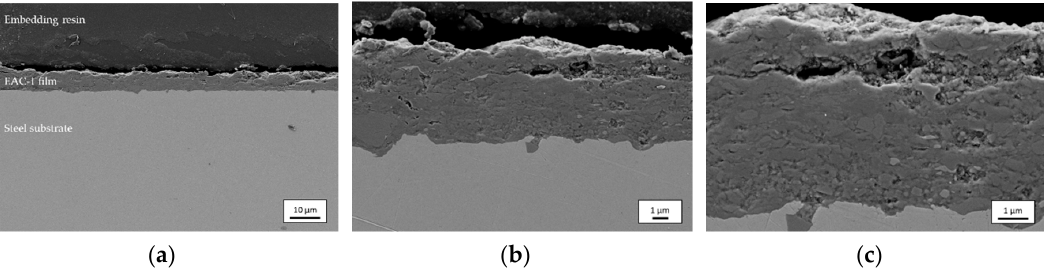
Figure 6. SEM cross-section of sample 3 at ( a ) 1000×, ( b ) 5000×, and ( c ) 10,000× magnification (SE detector). It was cut parallel to the traverse direction 10 mm from the right edge of the deposited film.